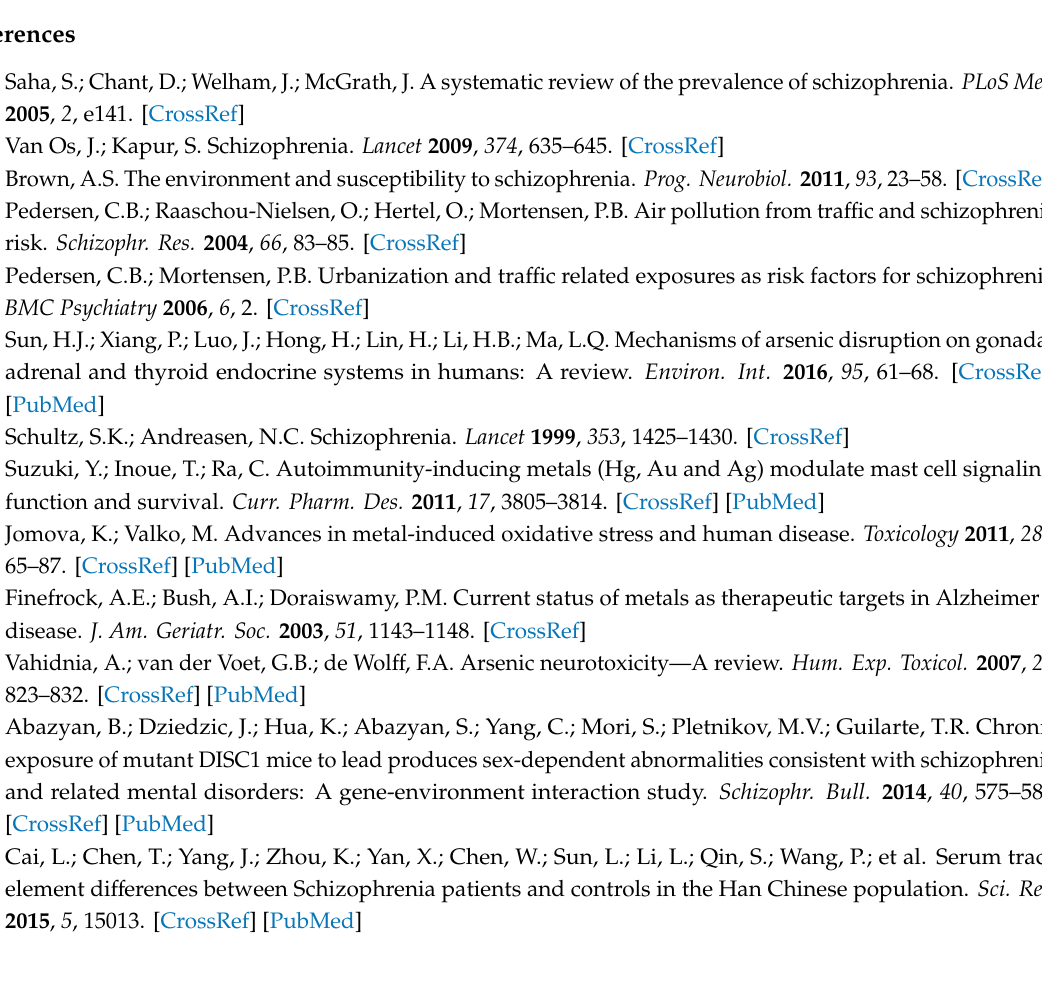
Table S1. Measured and standard concentrations of the certified reference materials; Table S2. Limit of detection and reproducibility of four THMs; Table S3. Main characteristics of included studies in the meta-analysis; Table S4. Results of meta-analysis of 4 THMs; Figure S1: Forest plot of subgroup analysis stratified by whether the patients with schizophrenia treated with antipsychotic drugs (without present study). Overall pooled prevalence was calculated by random-e ff ects module. Horizontal bars show 95% CIs. drug = 1, patients with schizophrenia were treated with antipsychotic drugs. drug = 0, patients with schizophrenia were not treated with antipsychotic drugs; Figure S2. Sensitivity analysis through deletion of one study at a time to reflect the influence of the individual dataset to the pooled SMDs of the THM concentrations in patients with schizophrenia and healthy